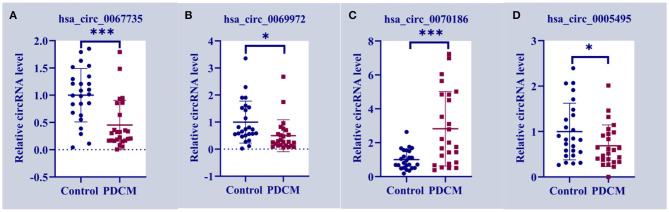
Circulating expression levels of the four circRNAs assessed by qRT-PCR. (A) Circulating expression levels of hsa_circ_0067735 in control subjects and the children with pediatric dilated cardiomyopathy (PDCM). (B) Circulating expression levels of hsa_circ_0069972 in control subjects and the children with PDCM. (C) Circulating expression levels of hsa_circ_0070186 in control subjects and the children with PDCM. (D) Circulating expression levels of hsa_circ_0005495 in control subjects and the children with PDCM. Control group, n = 25; PDCM group, n = 25. *P < 0.05 vs. control; ***p < 0.001 vs. control.